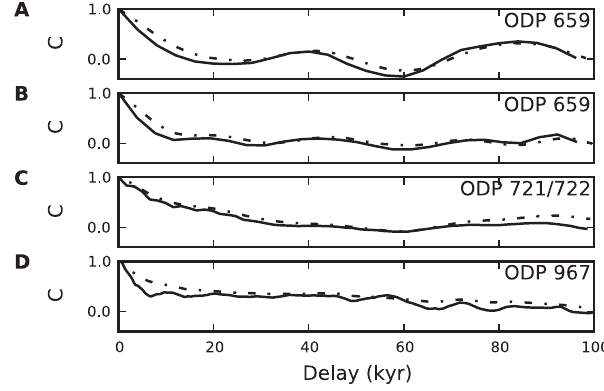
Fig. 3. Linear autocorrelation functions C(τ) for (A) the δ 18 O